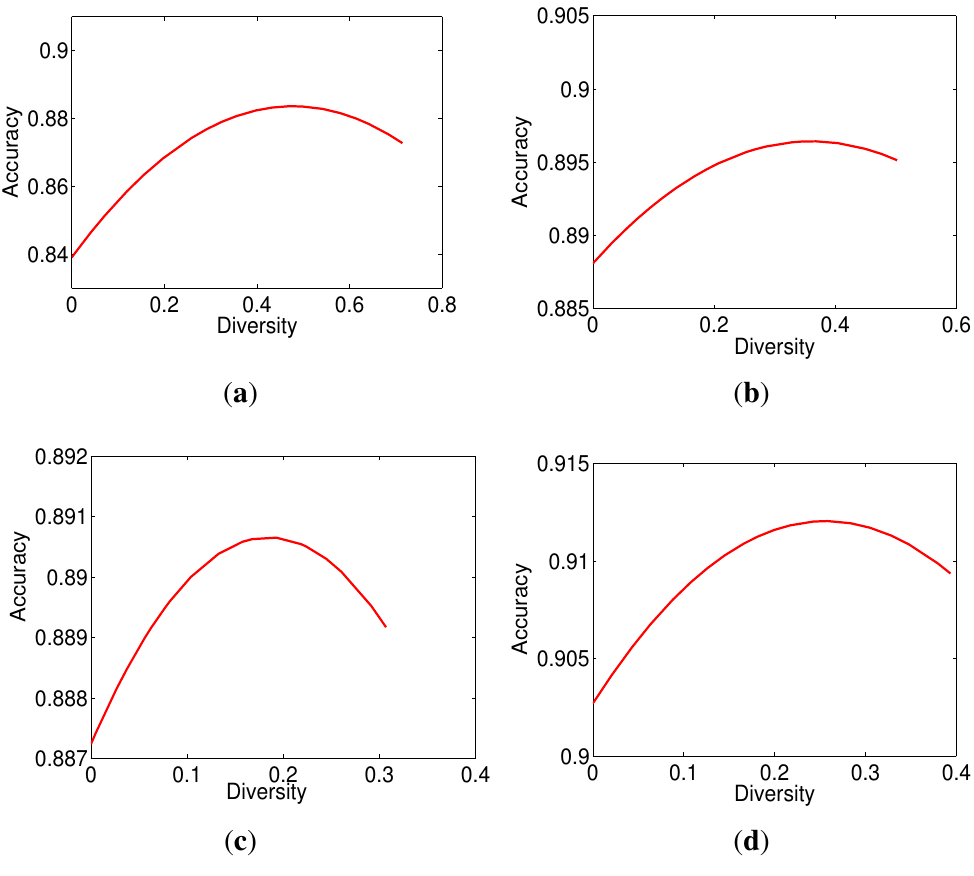
Figure 9. A demonstration of the diversity/accuracy dilemma on four public face